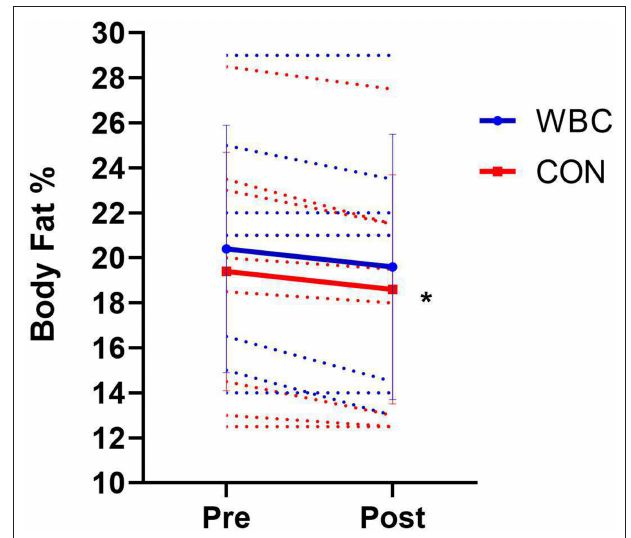
FIGURE 2 | Body fat percentages before and after the 6 week training programme for WBC ( n = 7) and CON ( n = 9) groups. * p < 0.05 for body fat decrease in CON. Solid lines present means ± standard deviations. Dotted lines present individual participant responses. N = 16.